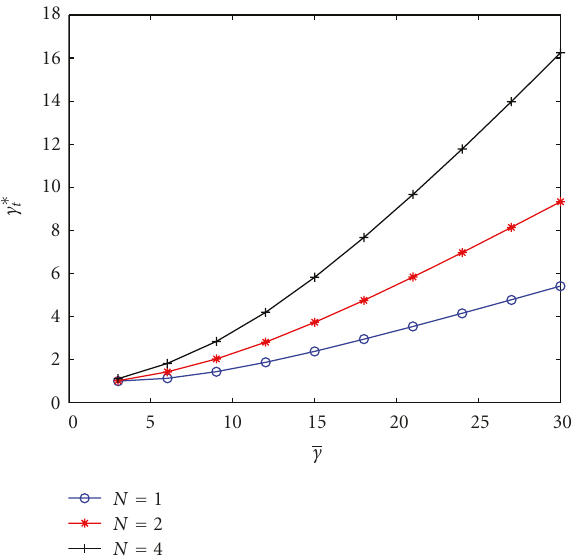
Figure 6: The e2e BER for all relaying protocols for N = 2 relays under random